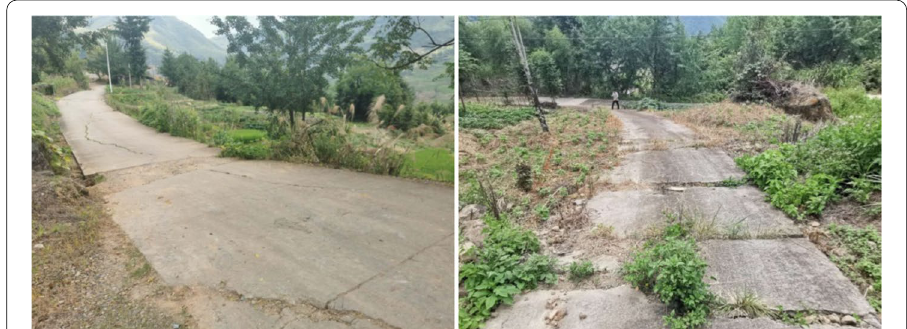
Fig. 5 Road cracking at the landslide body in Lianyun Village